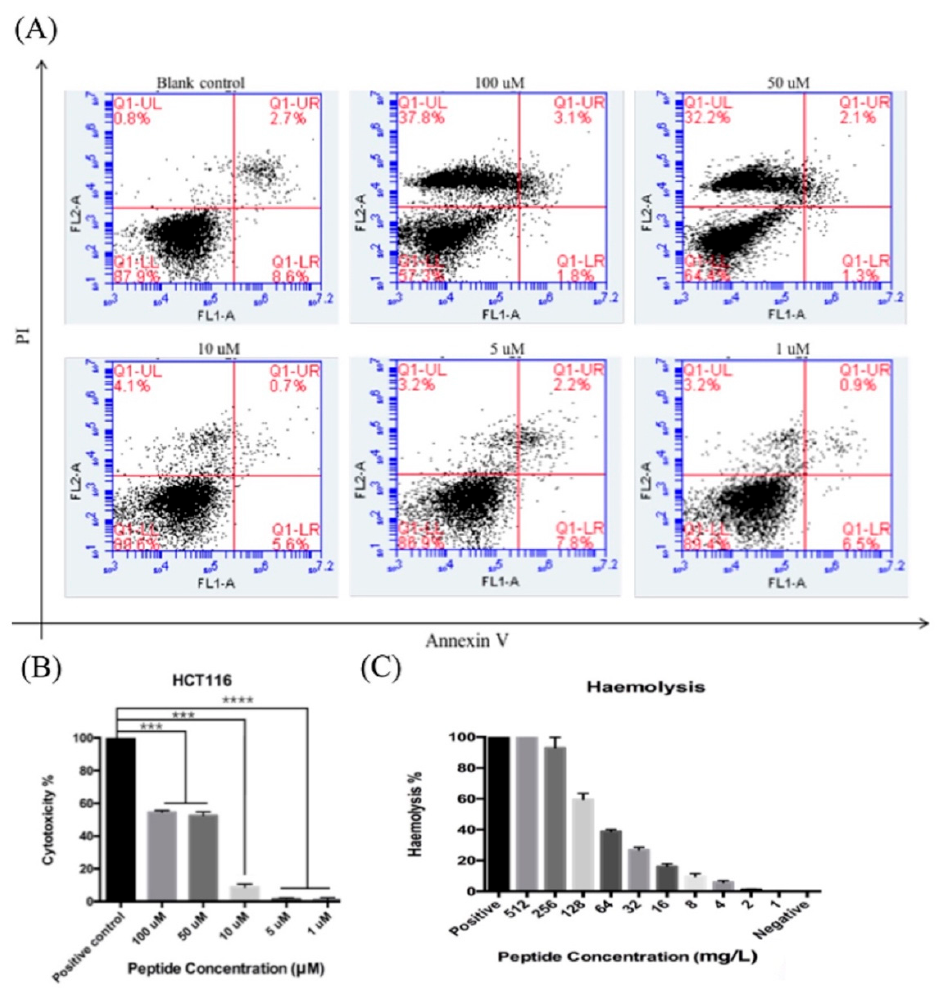
Figure 5. ( A ) The apoptotic and cell toxicity of LFB ( B ) Cytotoxicity of LFB on cancer cell HCT116. Cytotoxicity was calculated based on LDH release. The levels of significance are * p < 0.05; ** p < 0.01; *** p < 0.001; **** p < 0.001. ( C ) The hemolytic activity of synthetic LFB.